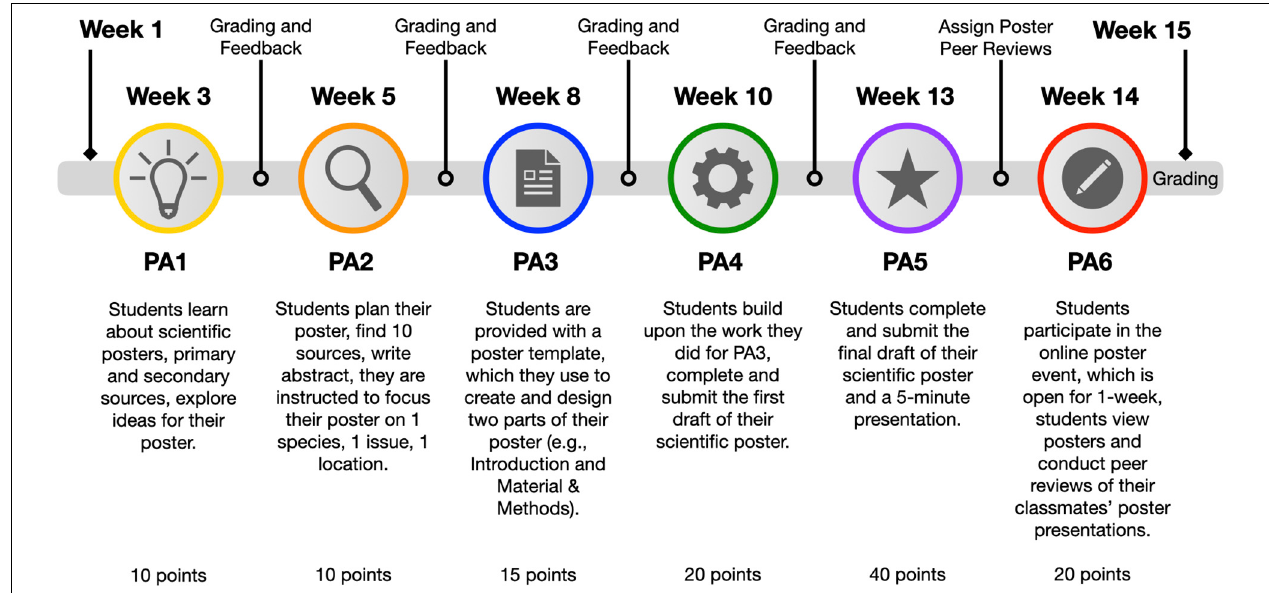
FIGURE 1 | Students were surveyed about their experience with poster assignments and asynchronous online poster event. Students responded to each question by selecting 1 of 5 responses: strongly agree (blue), agree (green), neutral (yellow), disagree (orange), strongly disagree (red). A total of 3,167 students from six different asynchronous, online courses participated in surveys. Class sizes ranged from approximately 400 students to 725 students. Students completed surveys at the end of the semester (i.e., Week 15) after they had completed all poster assignments. Surveys data collected during the following semesters: Spring 2018, 2019, 2020, 2021 and Autumn 2020 and 2021. All student responses were